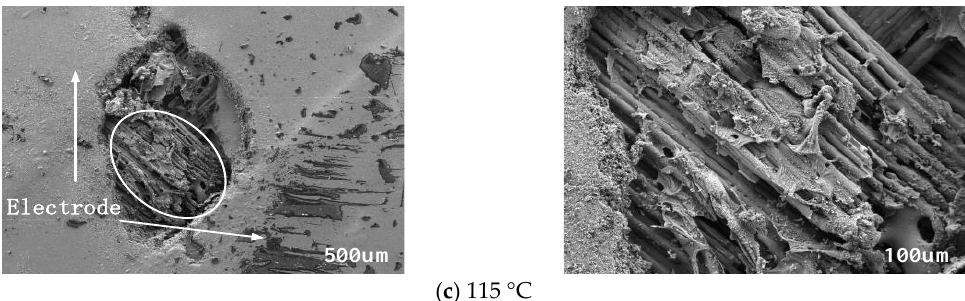
Figure 8. Surface morphology of the PCB breakdown channel by SEM under different temperatures.